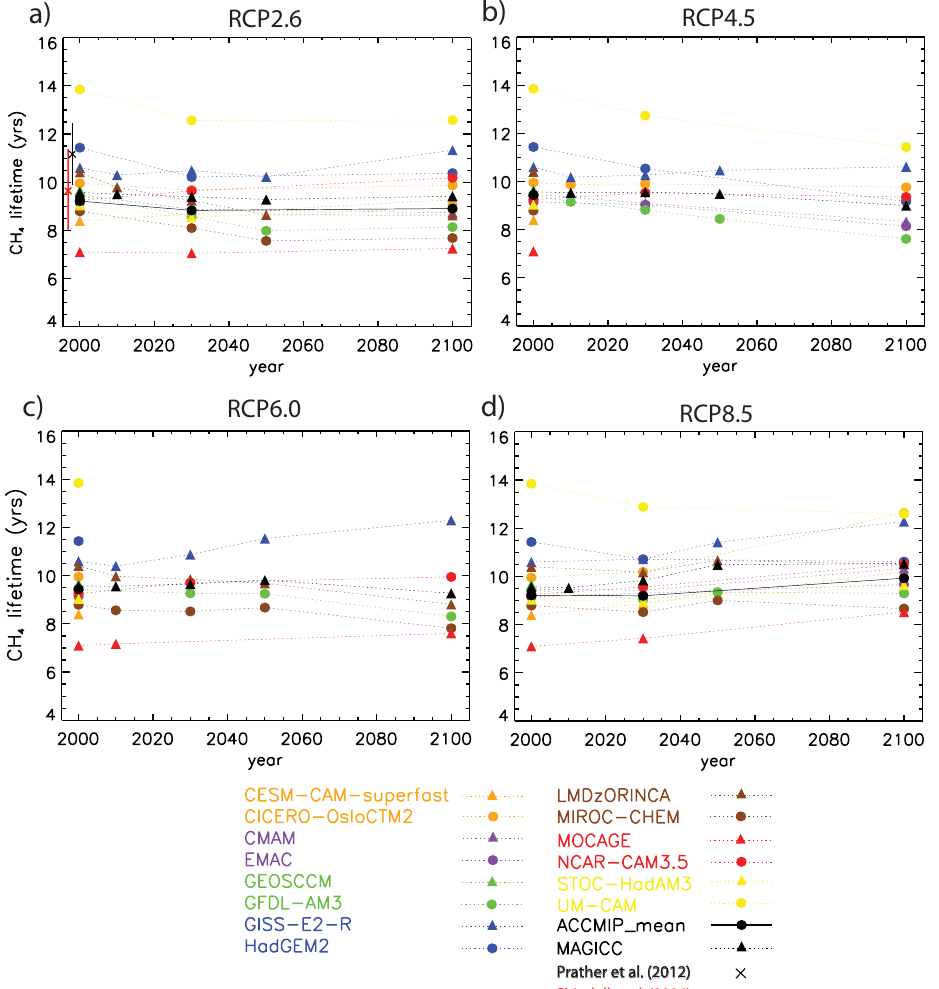
Fig. 2. Evolution of global tropospheric chemical methane lifetime in the ACCMIP models, for the four future RCP scenarios. Multi-model mean values (black dots connected with solid line) were only plotted for timeslices with data from at least 7 models, after removing results from CICERO-OsloCTM2, HadGEM2 and UM-CAM. For comparison, the dotted black line with square points shows the lifetimes used in the MAGICC integrated assessment model. Also, in the upper left panel, the red cross for present day shows the mean chemical lifetime from the ACCENT models (Shindell et al., 2006b), and the black cross is the observationally-based estimate made by Prather et al. (2012).